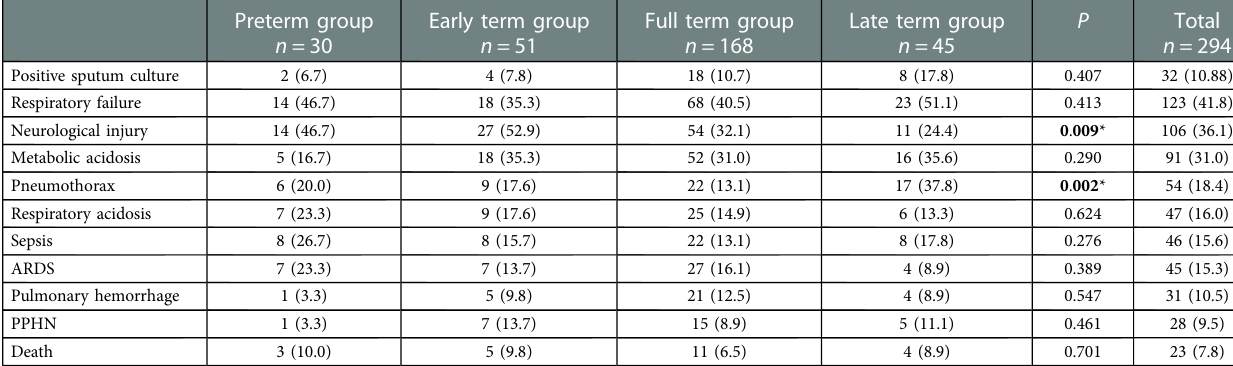
TABLE 4 Comparison of complications and regression of patients with different gestational age [ n (%)].